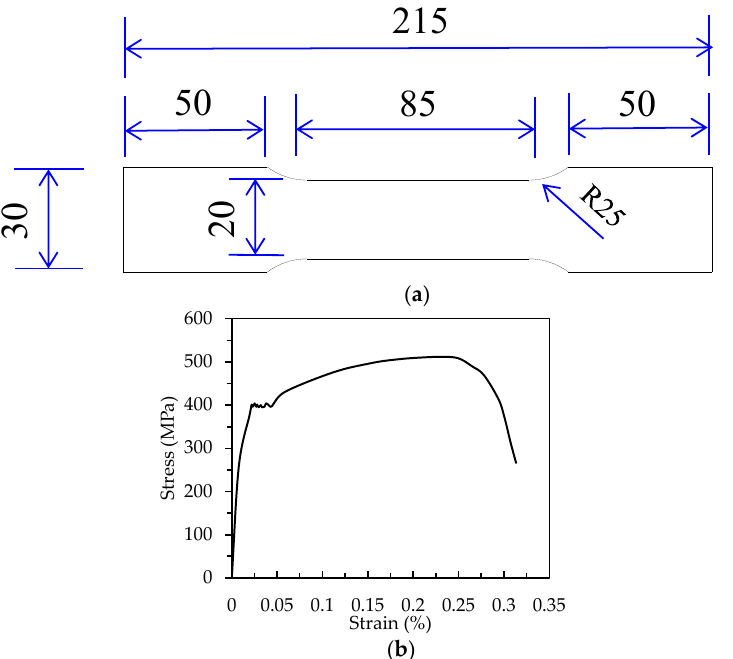
Figure 6. Design and results of material property test: ( a ) the nominal size of coupon specimen; ( b ) stress-strain curve.